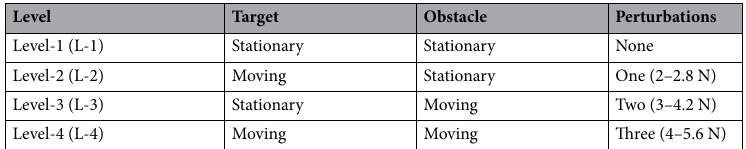
Table 1. Design of each level in obstacle avoidance task. The testing conditions for each level vary in terms of the stationary or moving targets and obstacles and the applied perturbations; the minimum and maximum net force applied to generate perturbations are provided in the last